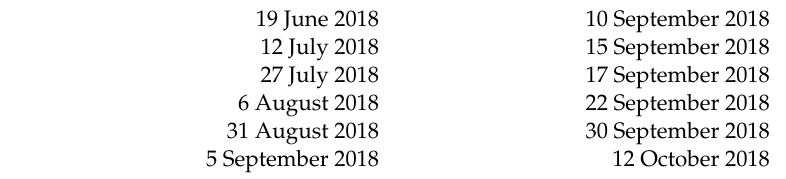
Table A2. Dates of the 12 Sentinel-2 images used for detecting hot volcanic